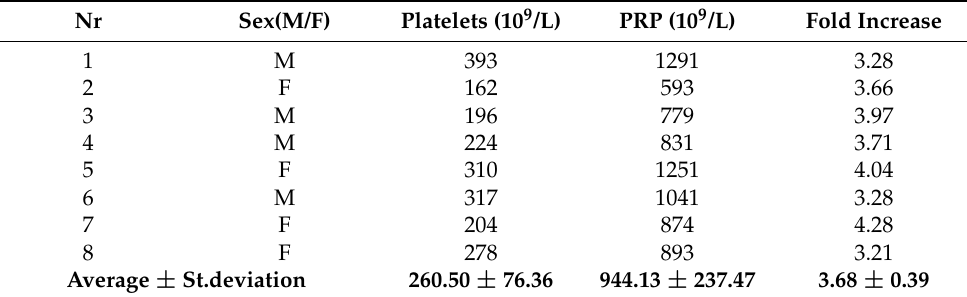
Table 2. Individual PRP characteristics in PRP-voice rest